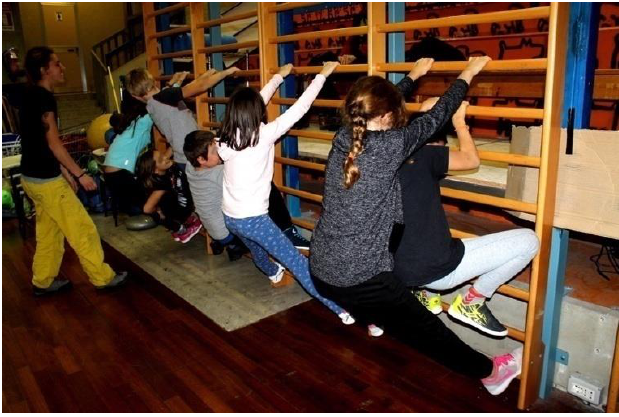
Figure 2. Overview of spider and crab positions.